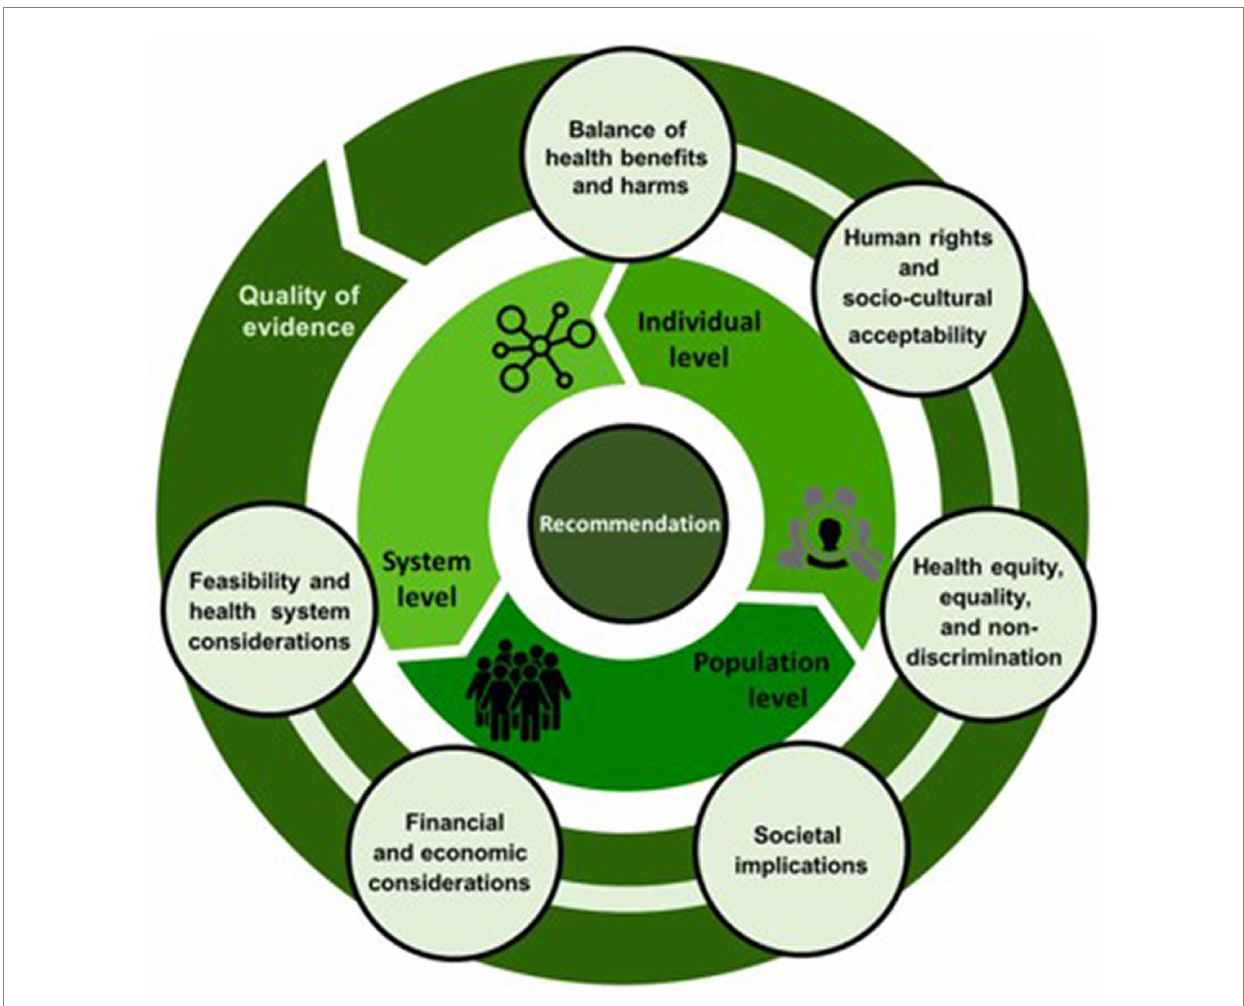
FIGURE 1 The WHO-INTEGRATE Evidence-to-Decision framework version 1.0 ( 9 )